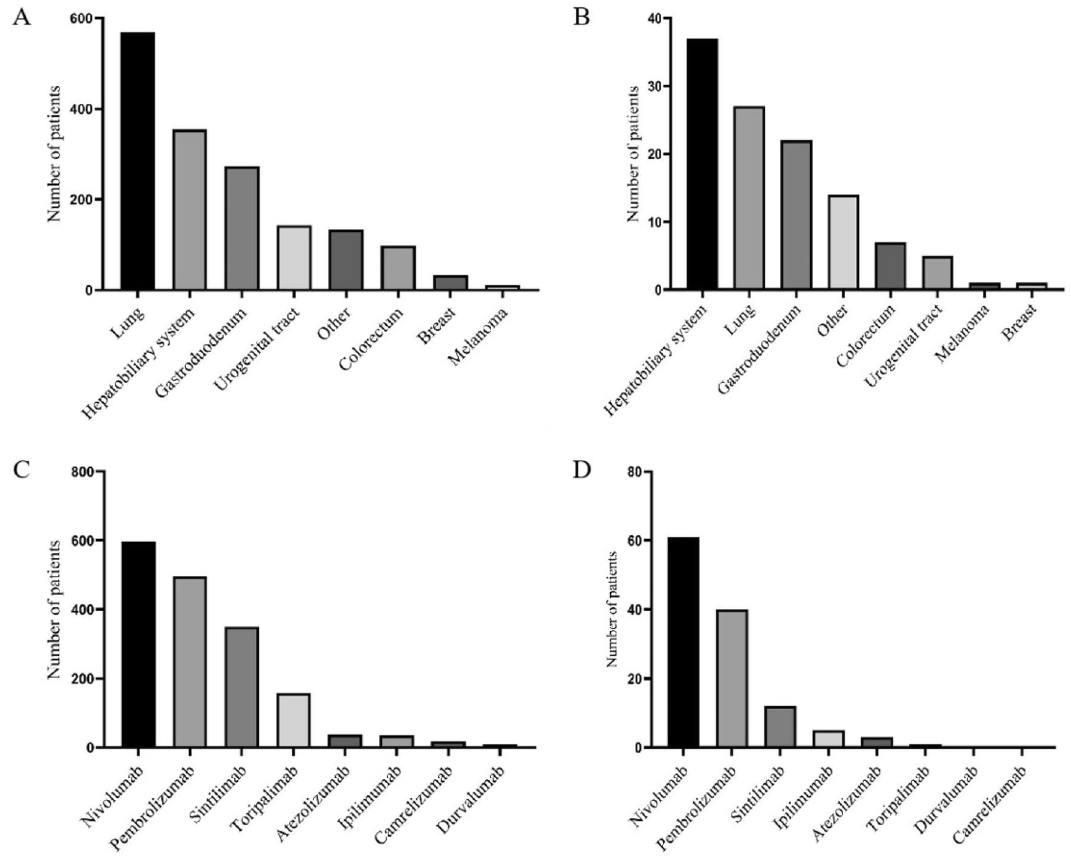
Figure 2. Distribution of tumor types in patients treated with ICIs ( A ). Distribution of tumor types in patients with AKI after treatment with ICIs ( B ). Distribution of ICI usage ( C ). Distribution of ICI use in AKI patients ( D